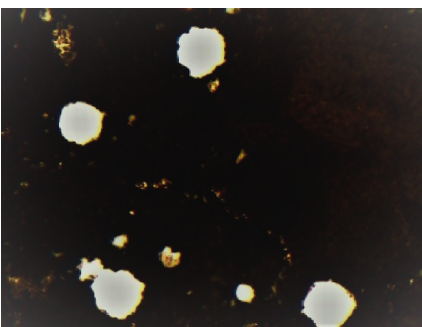
Figure 10: Bubble imaging of GO0 after 100 salt-frost